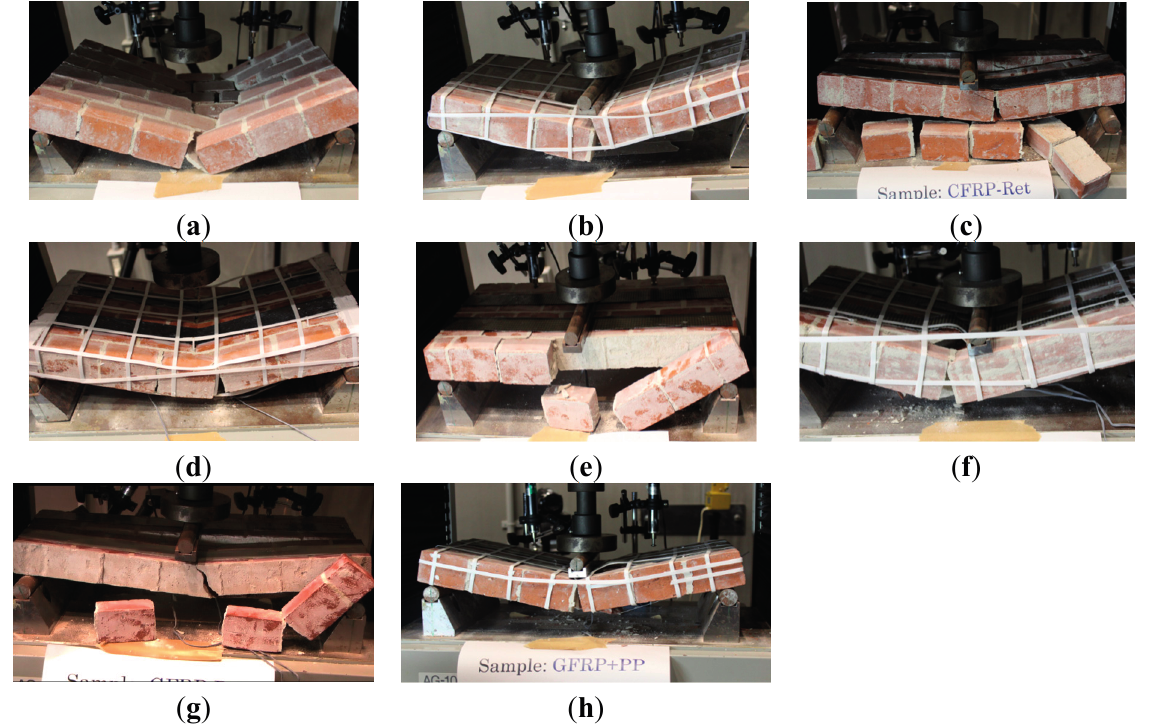
Figure 6. Failure mode and cracking pattern of Type-1 masonry panels under out-of-plane bending test for ( a ) URM, ( b ) PP-band retrofitted, ( c ) CFRP retrofitted, ( d ) CFRP + PP-band retrofitted, ( e ) AFRP retrofitted, ( f ) AFRP + PP-band retrofitted, ( g ) GFRP retrofitted, and ( h ) GFRP + PP-band